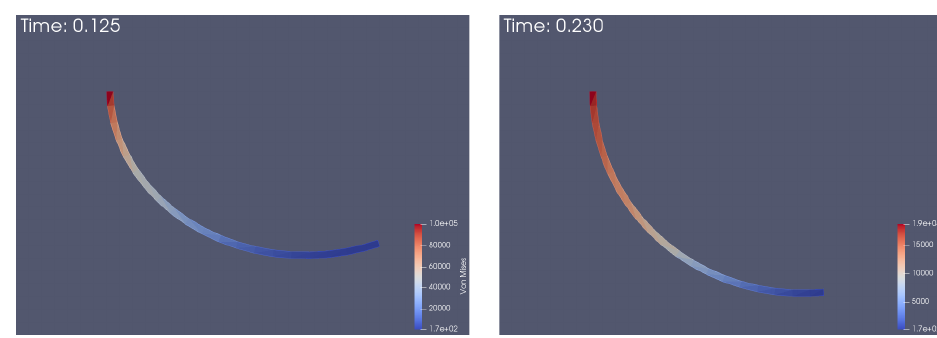
Figure 9. Von Mises stress distribution in the structure for V max =